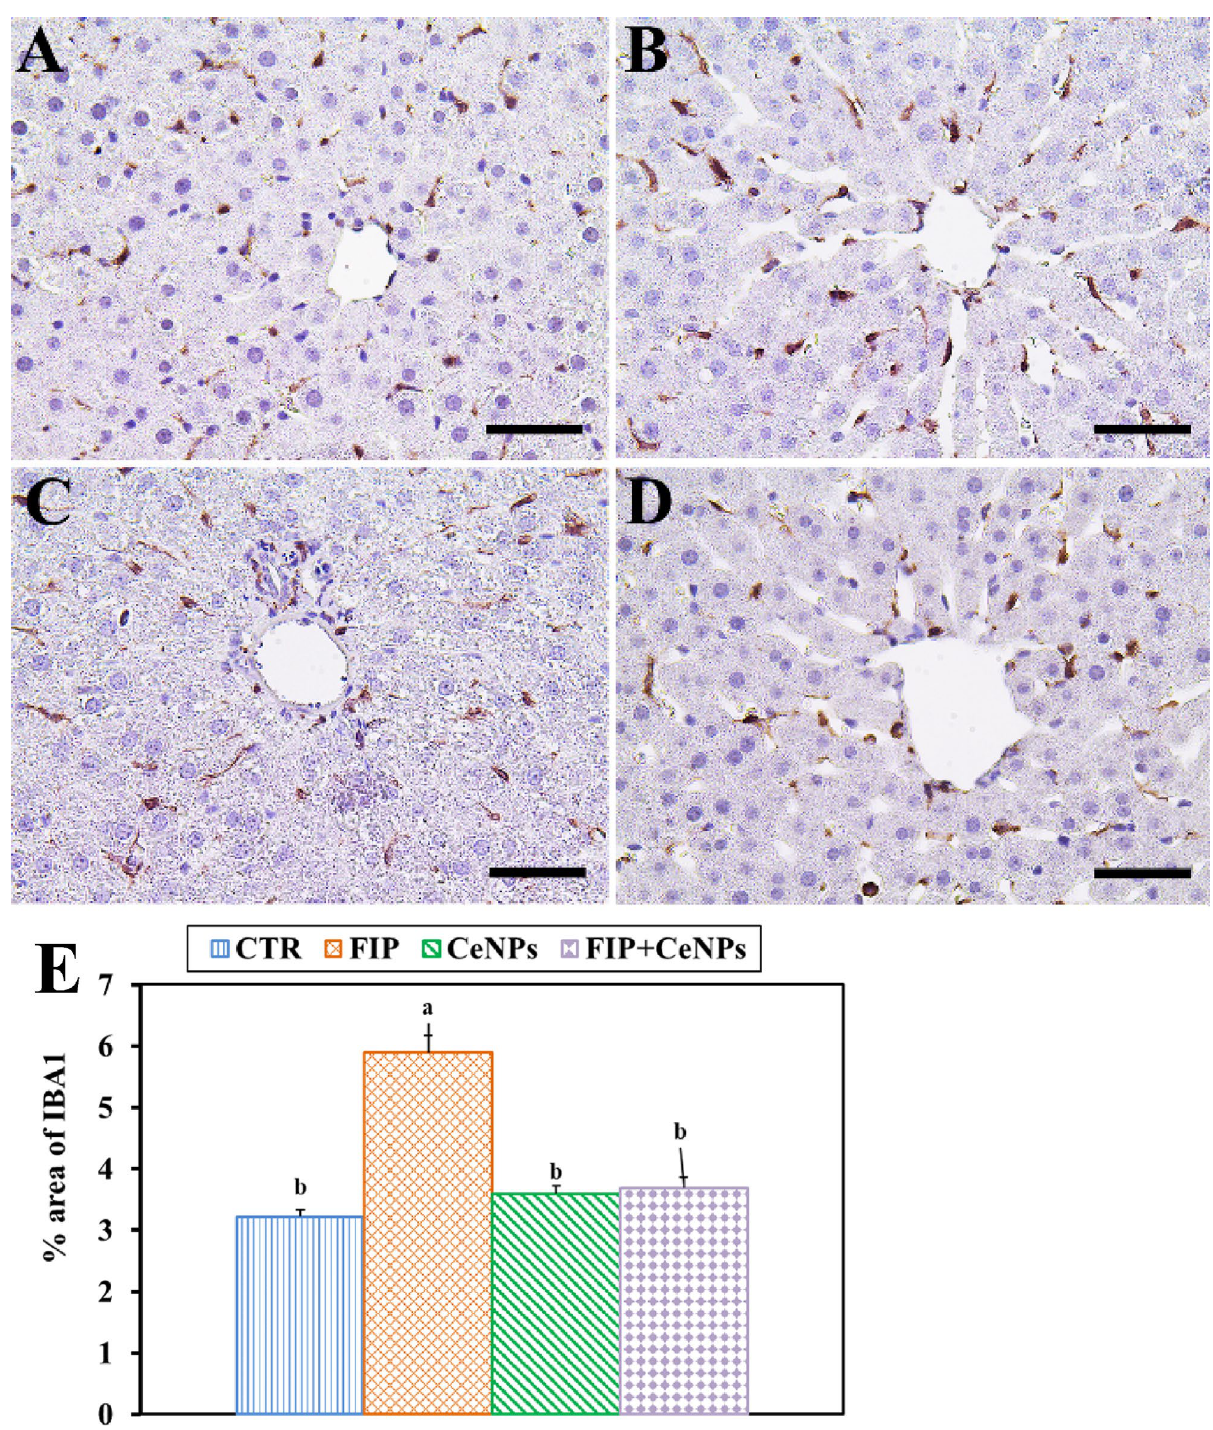
Figure 5. Immunohistochemical staining of rat liver by ionized calcium-binding adapter molecule 1 (Iba-1). ( A ) Negative control group. ( B ) CeNPs group. ( C ) FIP group. ( D ) FIP group that treated with CeNPs. Scale bar = 50 µm. ( E ) Quantification of I Iba-1 in the hepatic tissues in different groups. Data expressed as Mean ± SE, analyzed using one-way ANOVA at P ≤ 0.05, column with different letters (a & b) indicate significant difference among the values of different